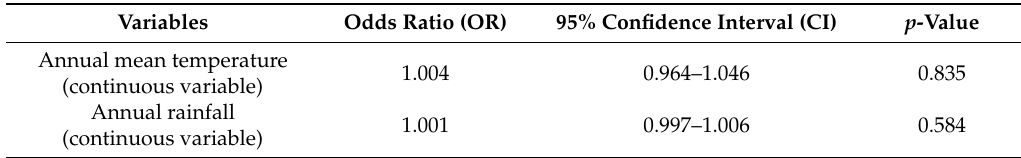
Table 3. Possible risk factors associated with higher Neospora caninum prevalence in sheep farms using univariate analysis.